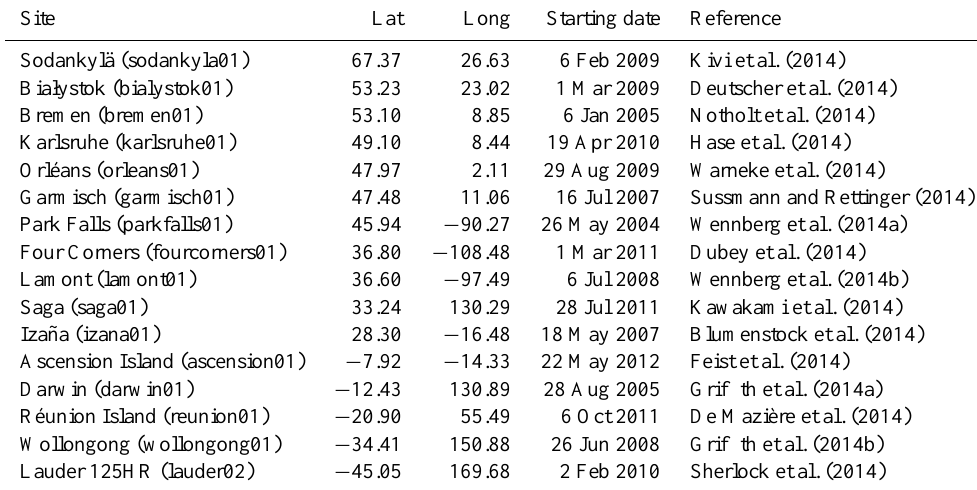
Table 1. List of the TCCON stations used, ordered by latitude from north to south. Site Lat Long Starting